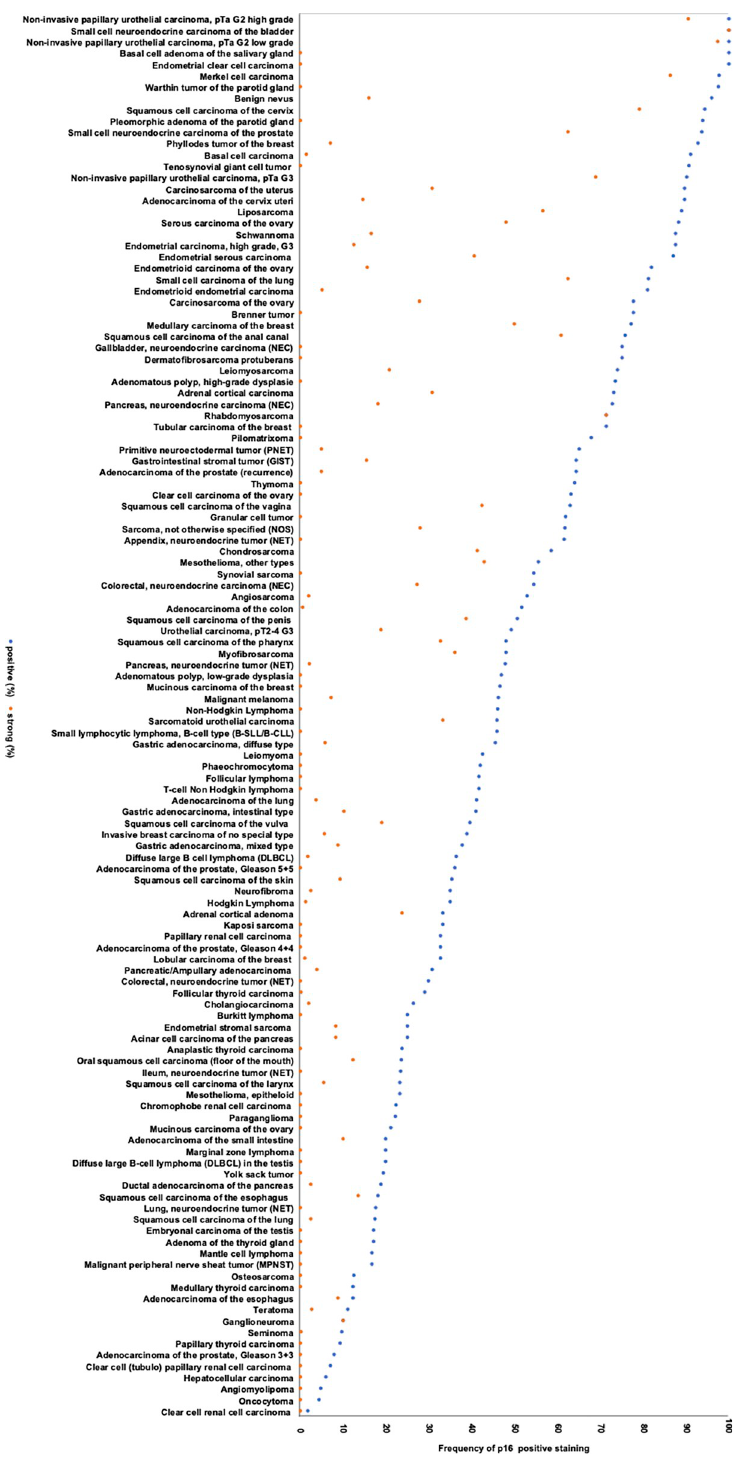
Fig 3. Ranking order of p16 immunostaining in human tumors. Both the frequency of positive cases (blue dots) and the frequency of strongly positive cases (orange dots) is shown.